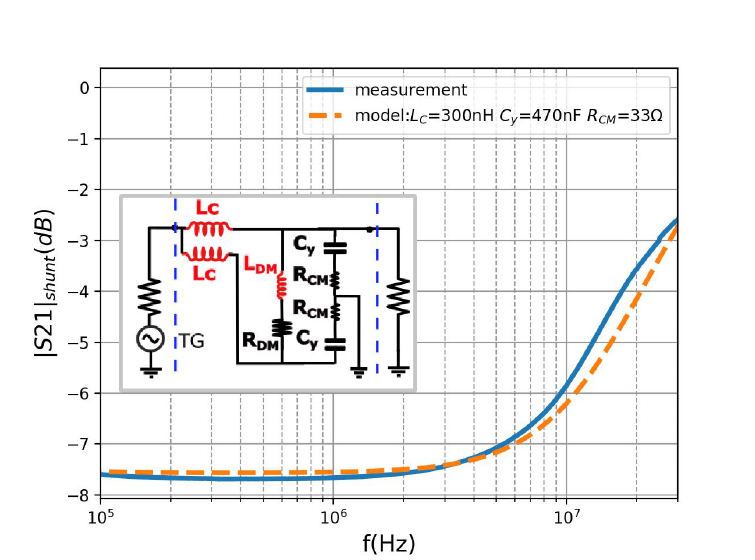
Figure A1. Measured and simulated transmission coefficient S 21 of the shunted CM load with the cables.